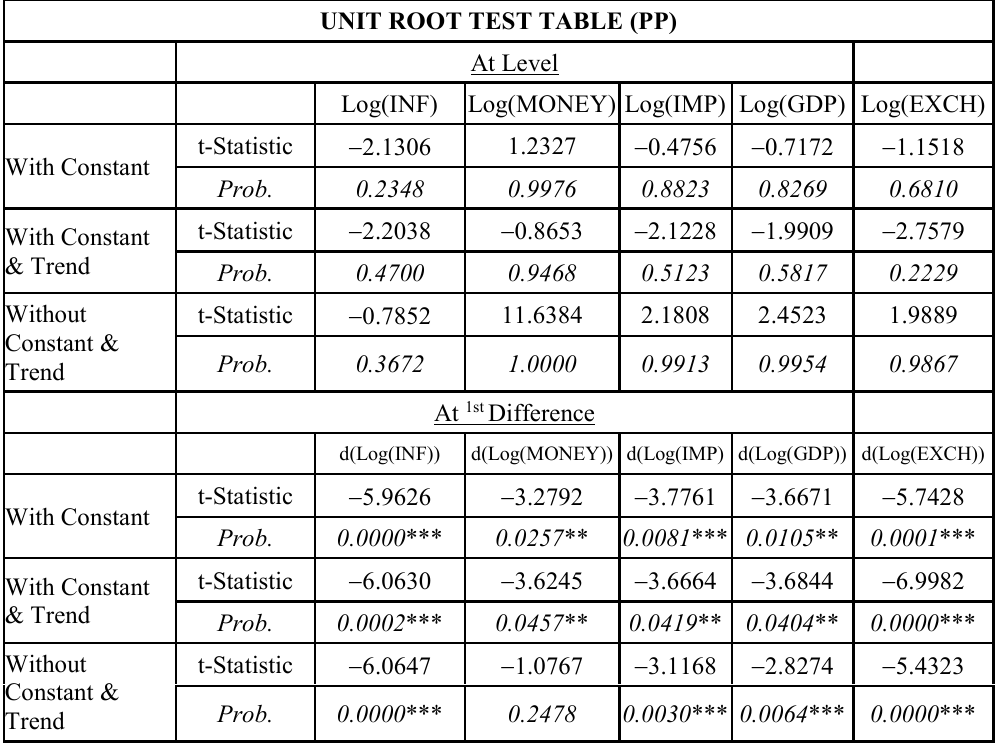
Table 4. Phillips Perron Unit-Root Test Results